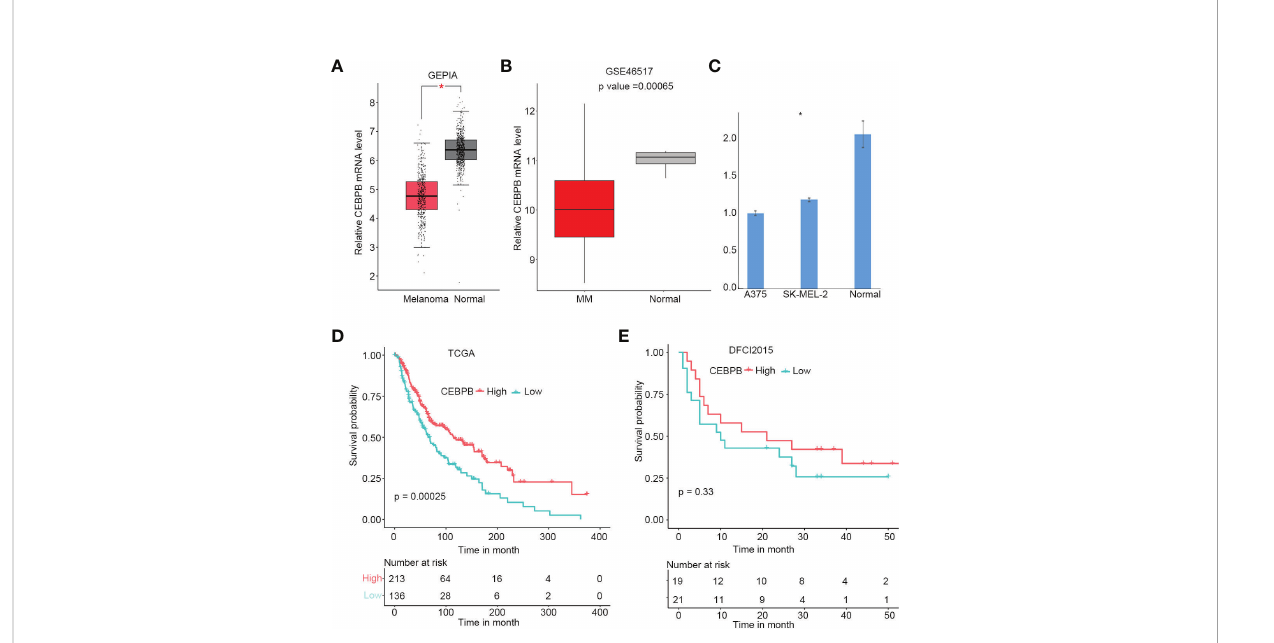
FIGURE 1 CEBPB is downregulated in metastatic SKCM and associated with superior prognosis. (A) Boxplot of relative CEBPB mRNA level in SKCM tumor samples from TCGA and normal skin samples from GTEx analyzed based on GEPIA. Asterisk indicates signi fi cant difference. (B) Boxplot of relative CEBPB mRNA level in metastatic SKCM tumor samples and normal skin samples from GSE46517. Exact p-value was provided. (C) Relative mRNA level of CEBPB in normal dermal fi broblast, A375, and SK-MEL-2 melanoma cell lines. (D, E) The KM survival probability curve of metastatic SKCM patients from TCGA-SKCM and DFCI2015 cohorts. The patients were grouped according to the best cut-point of CEBPB expression obtained through survminer R package. p-Value was determined by using log-rank test. SKCM, skin cutaneous melanoma; TCGA, The Cancer Genome Atlas; GTEx, Genotype-Tissue Expression; GEPIA, Gene Expression Pro fi ling Interactive Analysis; KM, Kaplan –